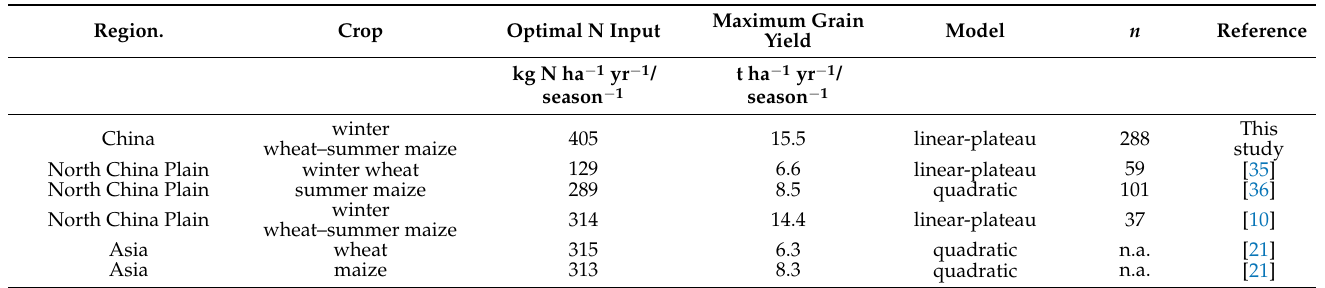
Table 1. Comparison of the estimated optimal N input rate (kg N ha − 1 yr − 1 /season − 1 ) and maximum grain yields (t ha − 1 yr − 1 /season − 1 ) for wheat and maize production in different regions. Region.